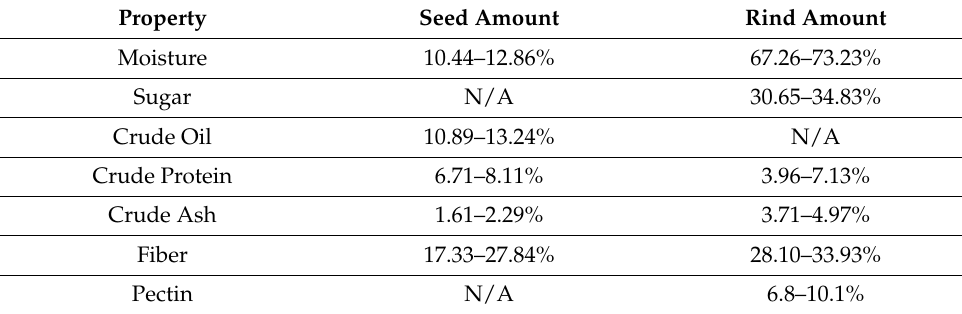
Table 1. Chemical properties of pomegranate seed and rind by dry weight [34,35].